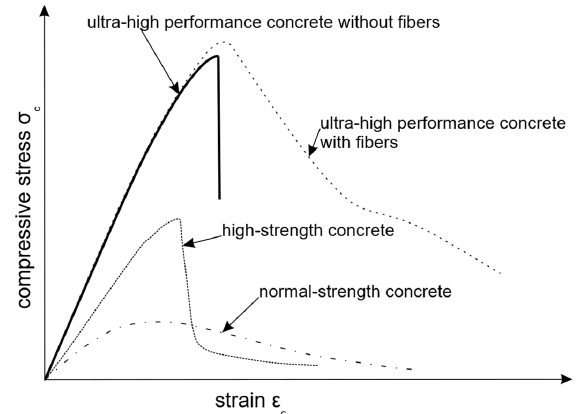
Figure 2. Typical stress-strain relationship of di ff er- ent types of concrete according to [7]